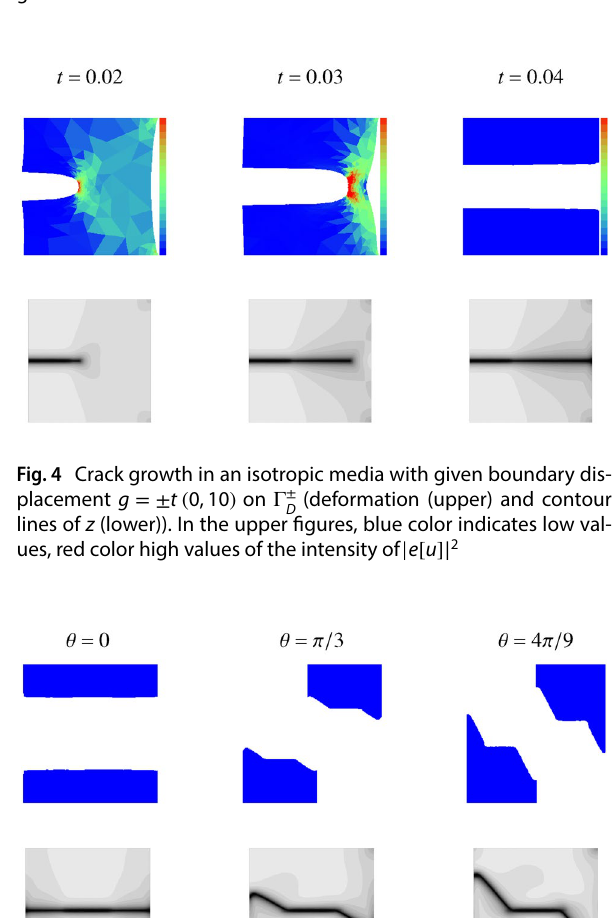
for θ = 0, π∕ 3, 4 π∕ 9 (defor- D